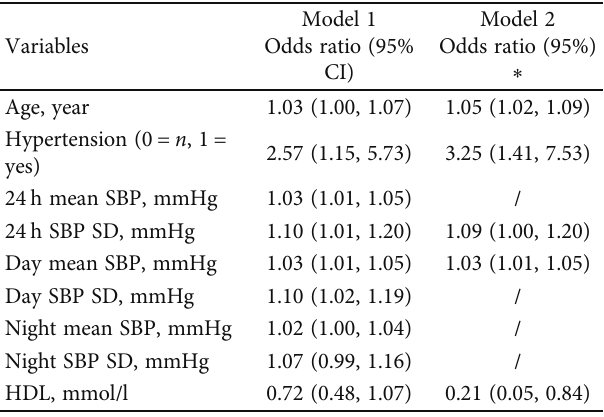
Table 3: The association of cSVD burden with blood pressure variability by ordinal logistic